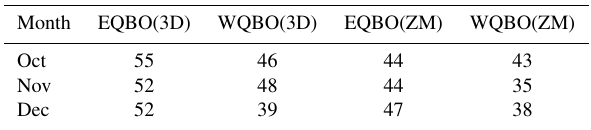
Table 2. The number of positive heat flux events during east and west QBO phases (defined in Sect. 2.2), for October–December, in the 3DO 3 and ZMO 3